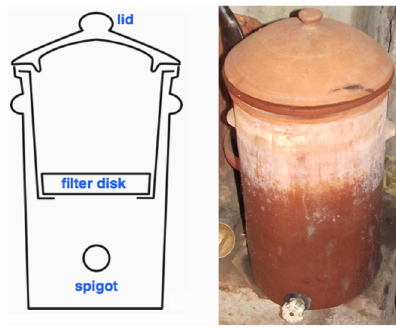
Figure 1. Schematic of the filter (adapted from [12]) and a picture of a filter used in one of the potters’ households (taken by the